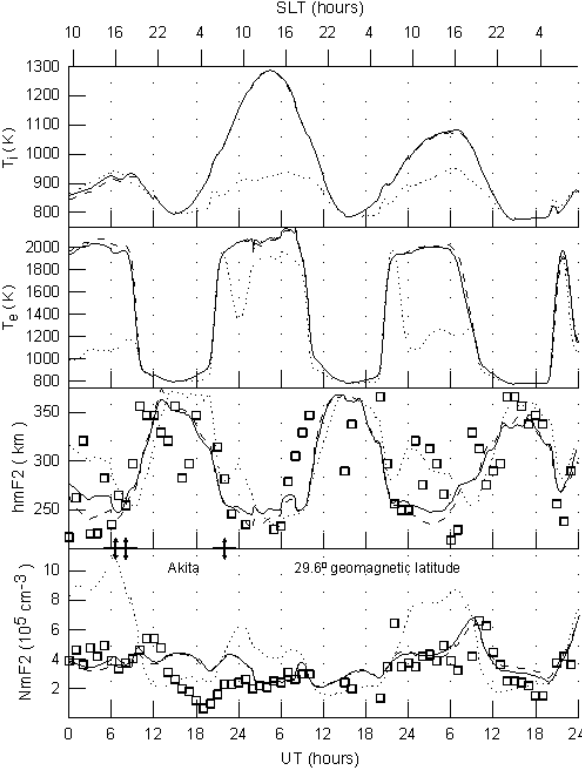
Fig. 8. From bottom to top, observed (squares) and calculated (lines) of NmF 2, hmF 2, electron temperatures and O + ion tem- peratures at the F 2-region main peak altitude above the Yamagawa ionosonde station during 25–27 August 1987. SLT is the solar lo- cal time at the Yamagawa ionosonde station. The start times of the sudden commencement (06:58 UT on 25 August), main phase (08:00 UT on 25 August) and recovery phase (22:00 UT on 25 Au- gust) of the geomagnetic storm are indicated by the arrows. The curves are the same as in Fig. 4.